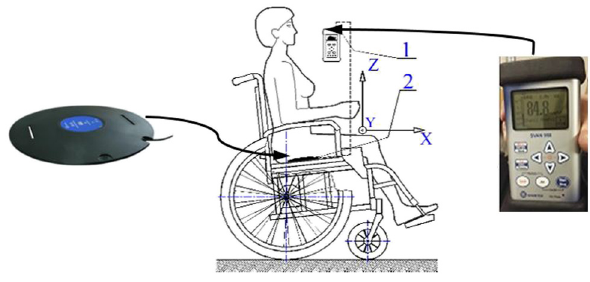
Figure 2: Location of the measuring disc and directions of vibration reception:1 – vibrationspectrumanalyzerand2 - discwithatriaxialsensor.